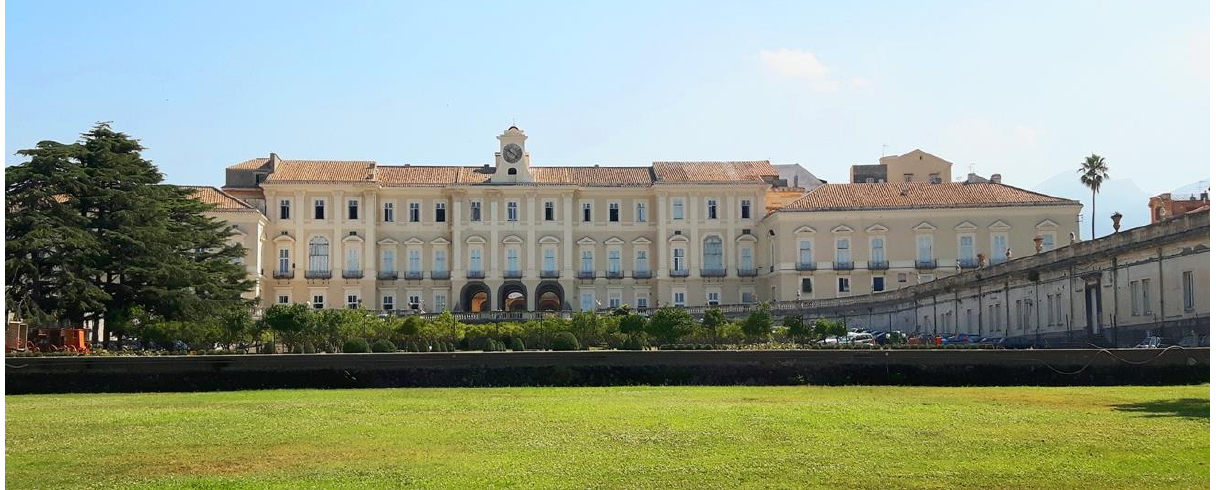
Figure 1. The royal palace in Portici (photo D. Treccozzi